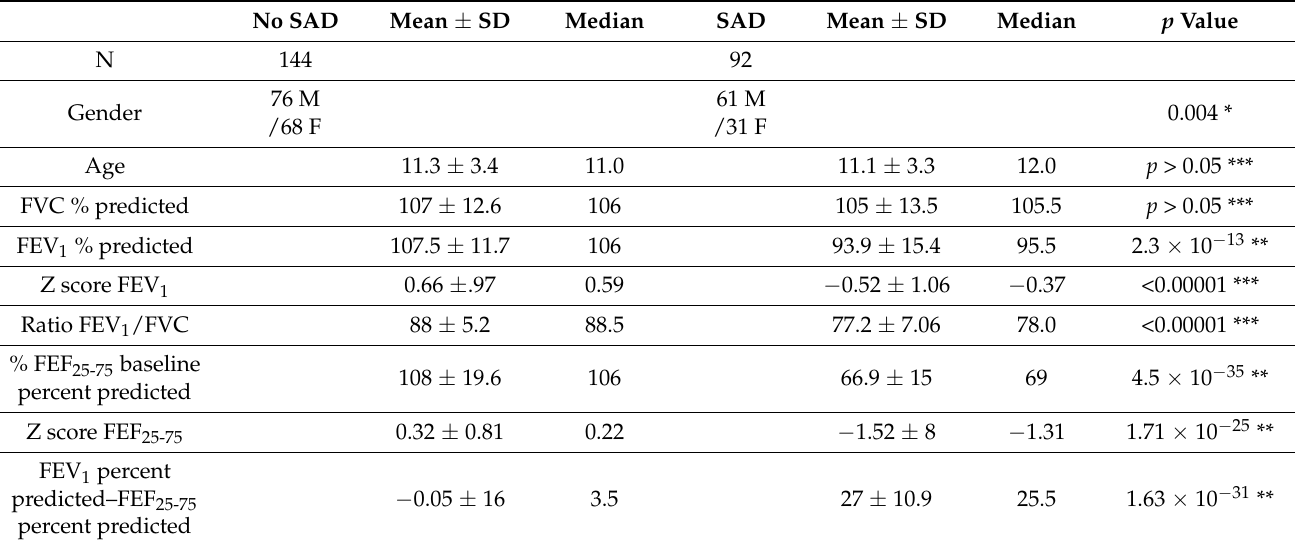
Table 1. Comparison of a priori selected No SAD and SAD